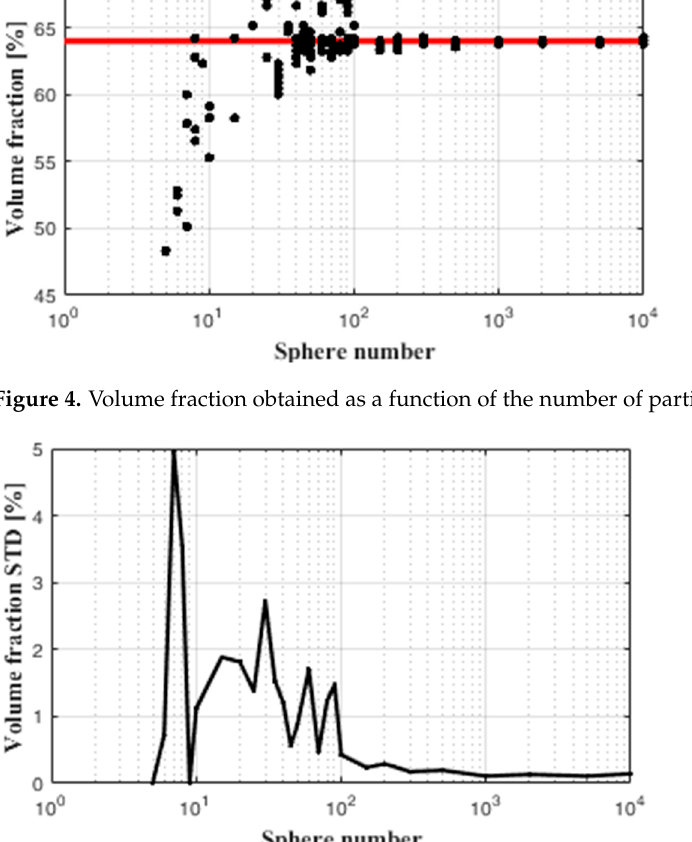
Figure 5. Volume fraction standard deviation for different numbers of particles.